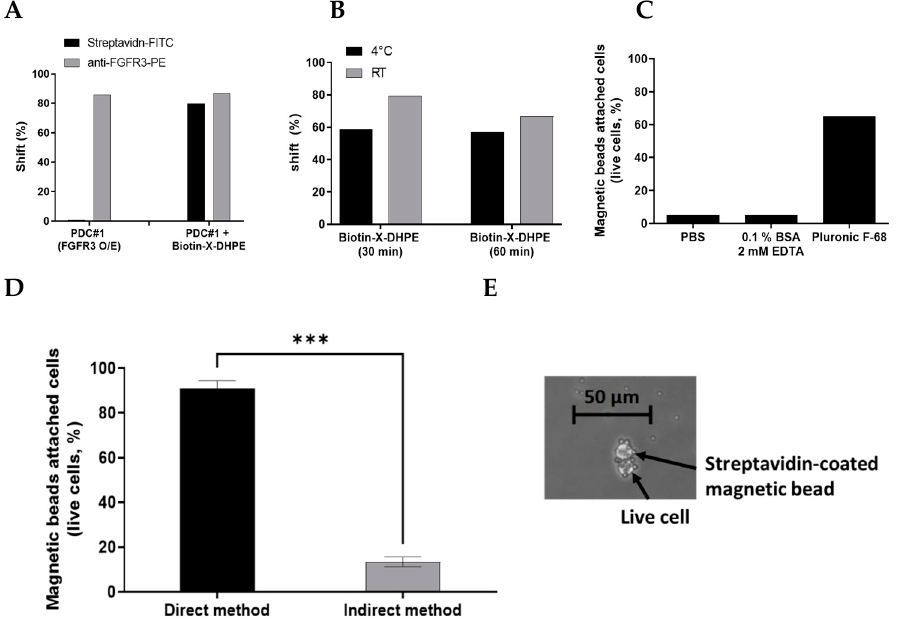
Figure 2. ( A ) Following biotin-X-DHPE labeling on FGFR3-overexpressing cells (PDC #1), FGFR3 expression levels on the cell surface were analyzed by FACS analysis. Biotin-X-DHPE was detected using Streptavidin-FITC, and FGFR3 was detected using PE-direct conjugated antibody. ( B ) The optimal reaction temperature and time for labeling the living cells with biotin-X-DHPE were analyzed by FACS analysis. ( C ) Optimal reaction buffer analysis for attaching magnetic beads on cells. ( D ) The capture yield of live cells attached with magnetic beads was compared using both direct and indirect method through cell counting and microscopic observation. *** p < 0.001 paired T test. ( E ) Microscopic observation of live cells attached with magnetic beads (magnification 400 ×